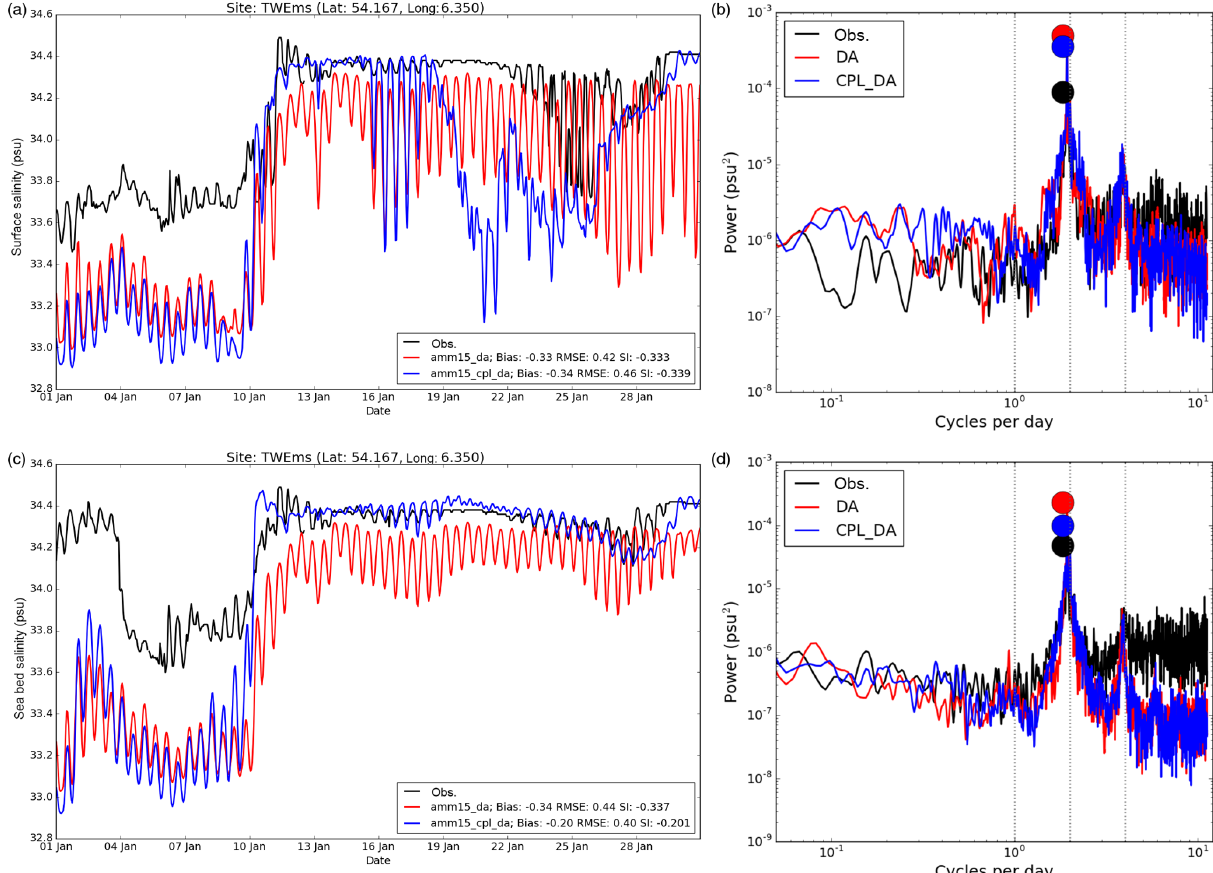
Figure 13. (a, c) Time series of observed and simulated salinity at (a) sea surface (SSS) and (c) seabed (SBS) during January 2017 from DA and CPL_DA simulations with observed values in the German Bight (buoy UFSDB). (b, d) Computed power spectra for observed, DA, and CPL_DA simulated SSS, and SBS during all of 2017. Filled circles highlight the amplitude of the peak power for each time series. Vertical dotted lines mark diurnal, semi-diurnal, and quarter-diurnal